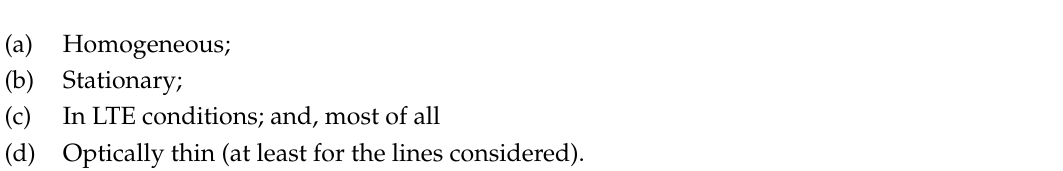
Figure 5. Determination of the unknown A ki of a spectral line from the knowledge of the composition of the sample. From the discussion on the determination of the Stark coefficients, it should be evident the limit of the above-discussed approaches.